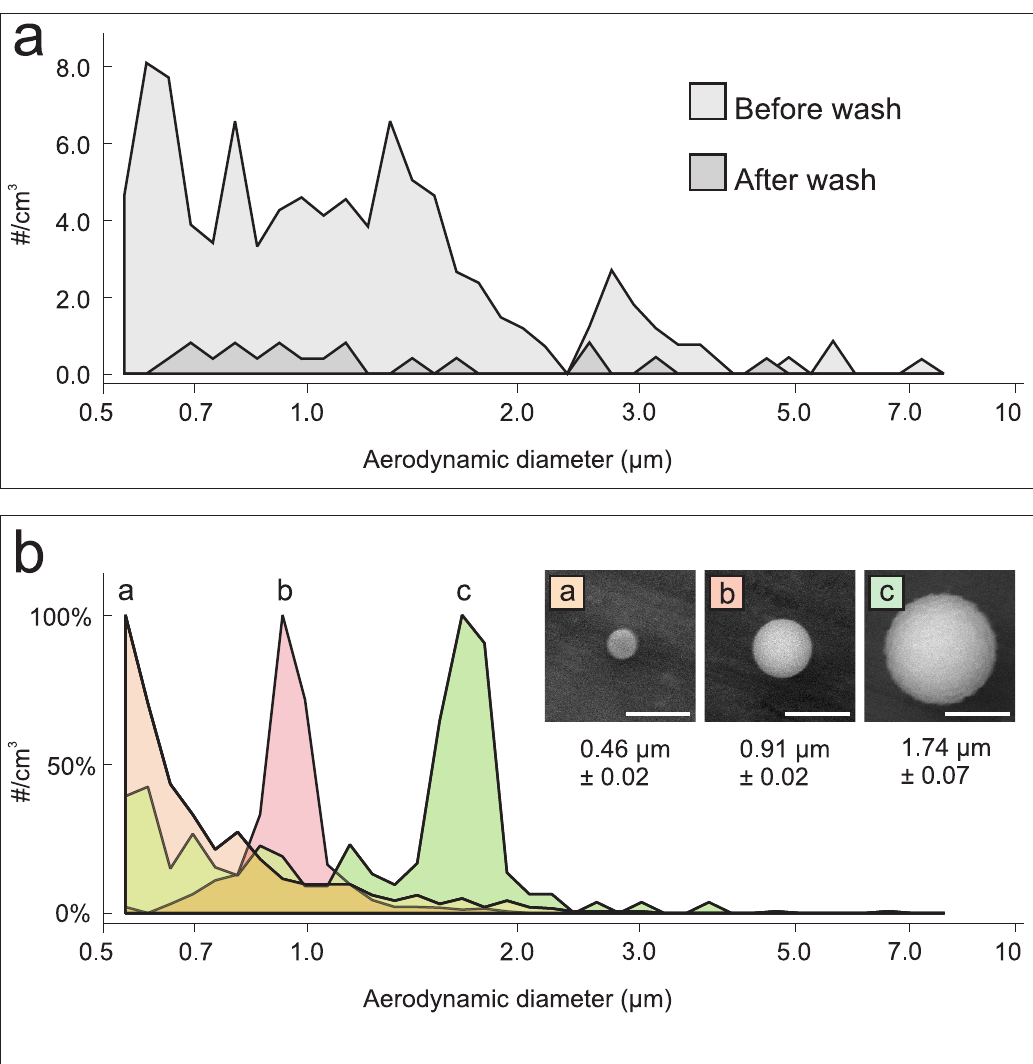
Fig 2. The in-built APS characterizes the particle size distribution spectrum within the RASC. (A) Typical background particle spectrum before and after air wash. Note the 10-fold decrease in particle counts across all size ranges following the air wash. Total count from a typical five seconds of sampling. (B) Artificial dry release of fluorescent polystyrene latex (PSL) microspheres. The APS instrument groups all particles with an aerodynamic diameter less than 0.523 μ m in the number bin on the far left of each chart. Note that the 1 μ m release (b) contained approximately ten times more particles in the release. Total count from ten seconds of sampling at the peak of particle concentration. (Inset) corresponding SEM images of the released